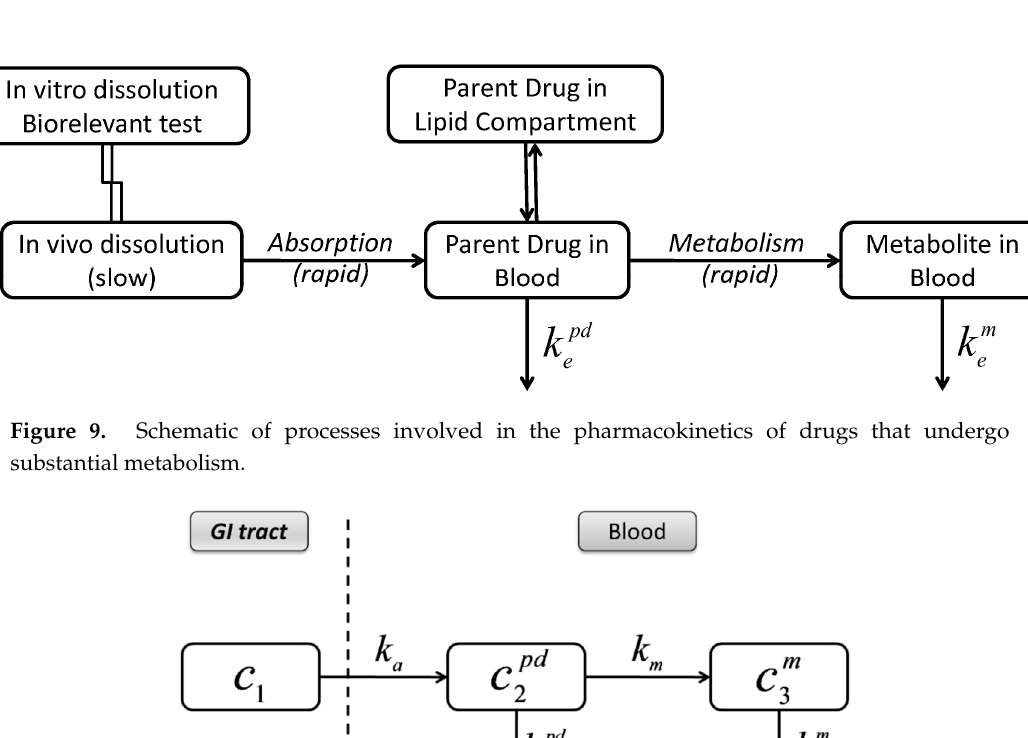
Figure 10. Simplified compartmental model describing the pharmacokinetics of DTZ and DTZM.